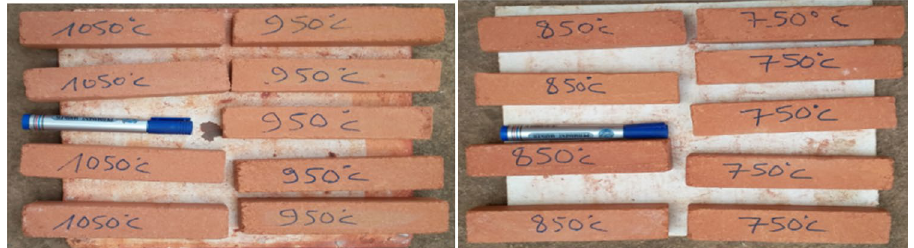
Fig. 5 Fired bricks at different temperatures